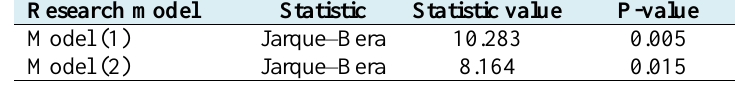
Tabel 12. The results of the normality of the error term in the TSE